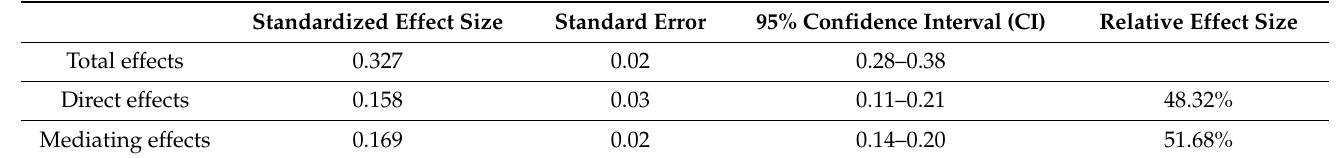
Table 5. Total effects, direct effects and mediating effects in the mediation model (bootstrap =